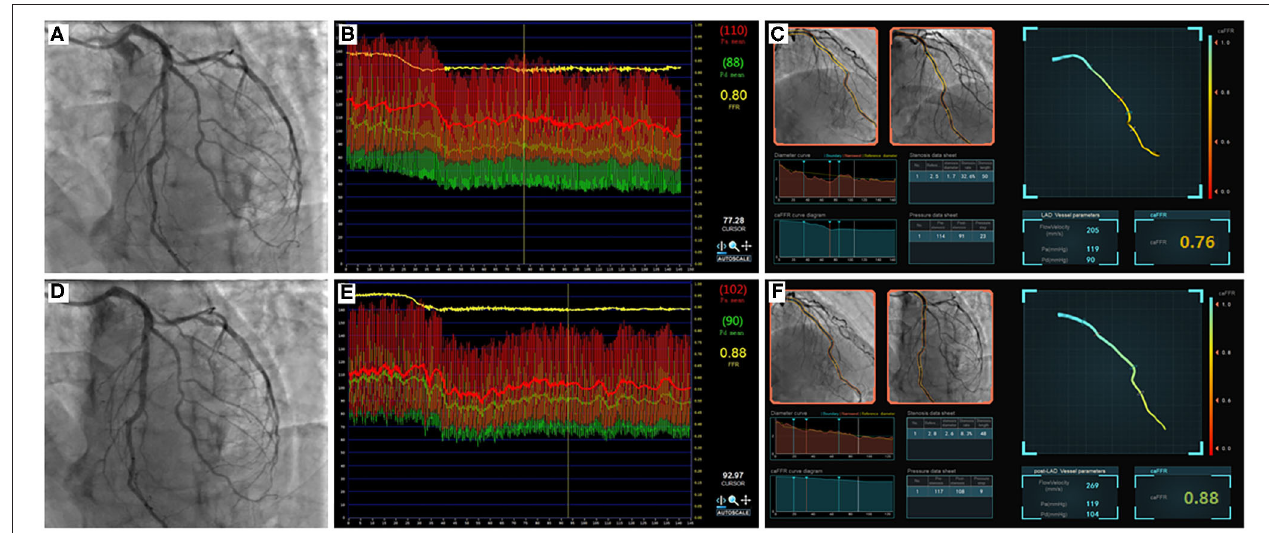
FIGURE 1 | Example of comparisons between pre- and post-PCI FFR and caFFR values. Images were obtained from a 61-year-old patient in the study. (A) Coronary angiography shows moderate stenosis lesion located in the middle of the LAD. (B) The value of pre-PCI FFR, measured by invasive pressure wire, was 0.80. (C) The pre-PCI caFFR value was 0.76. (D) Post-PCI coronary angiography after 2.5 × 24mm and 2.75 × 24mm stent implantation. (E) The invasive post-PCI wire-based FFR value was 0.88. (F) The post-PCI caFFR value was 0.88. LAD, left descending artery; FFR, fractional flow reserve; PCI, percutaneous coronary intervention; caFFR, coronary angiography-derived